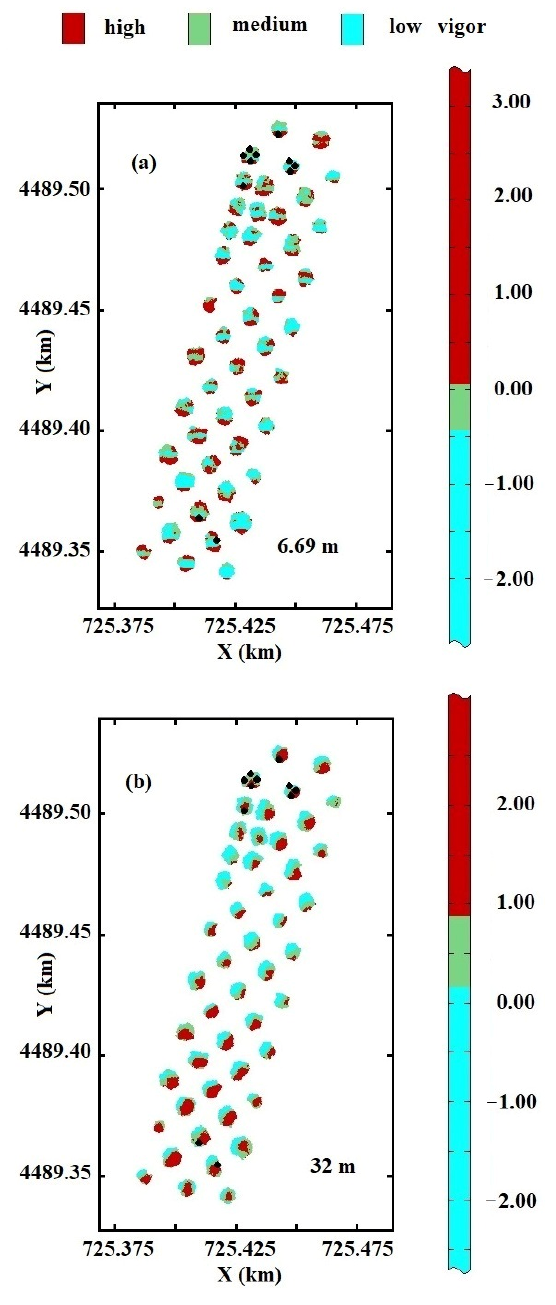
Figure 6. Maps of the first two regionalized factors at short range ( a ) and long range ( b ) with double color scale: qualitative and quantitative (3 isofrequecy classes) scales. Dots correspond to the crown sector classified by the operator as infected.